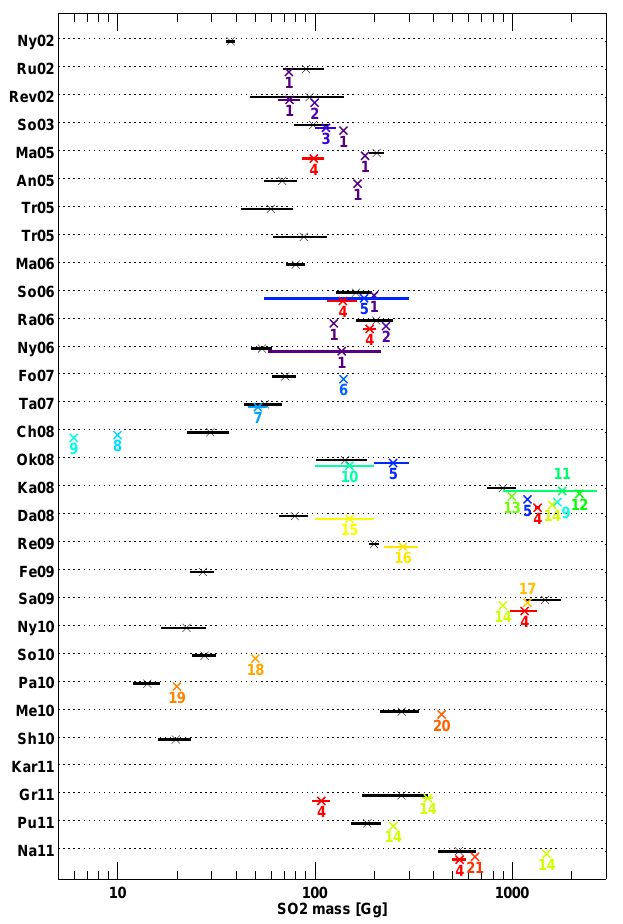
Figure 15. Graphical representation of total SO 2 eruption masses as listed in Table 3. Black: MIPAS, red: MLS, other colours: nadir instruments. The coloured numbers refer to the references given in Table 3.